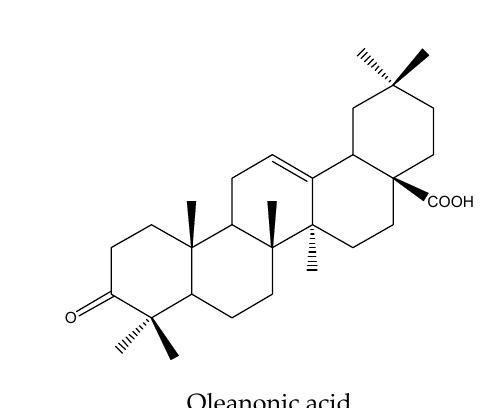
Figure 21. The structures of oleananes.